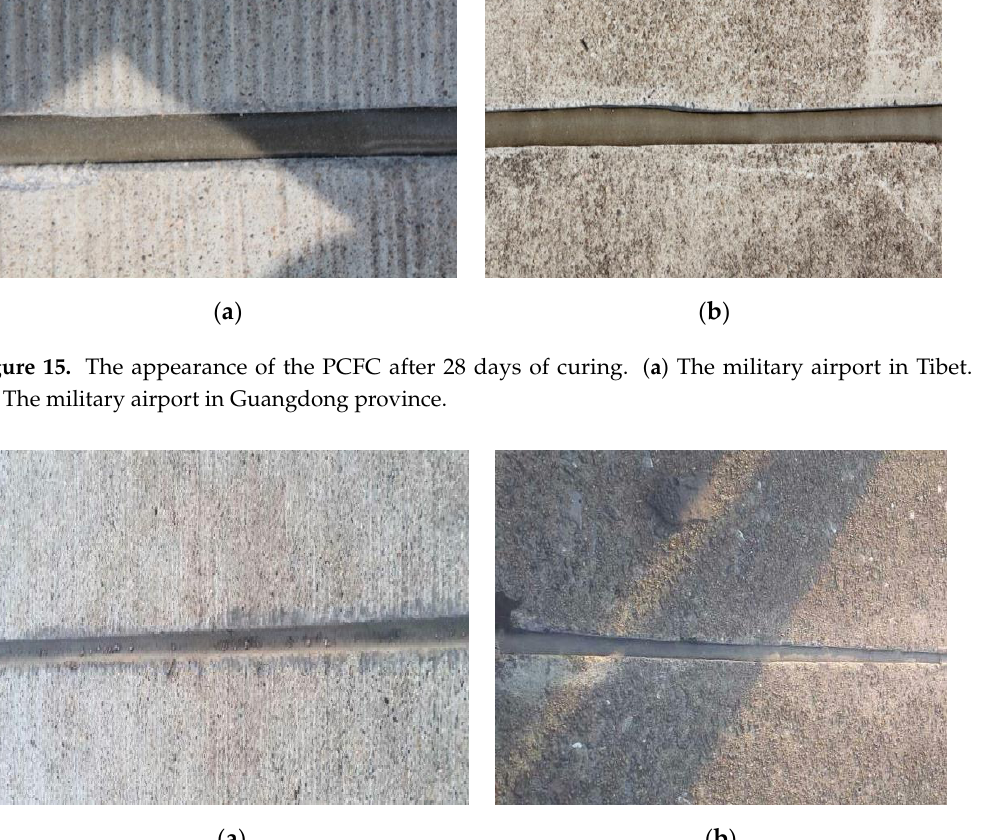
Figure 16. The appearance of the PCFC after two years. ( a ) The military airport in Tibet. ( b ) The military airport in Guangdong province.